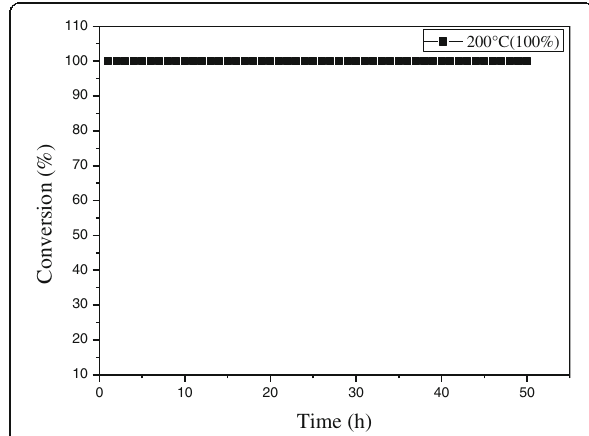
Fig. 13 The stability of 0.3% Au/Ce 0.75 -La 0.25 nanorods at the reaction temperature of 200 °C for CO oxidation